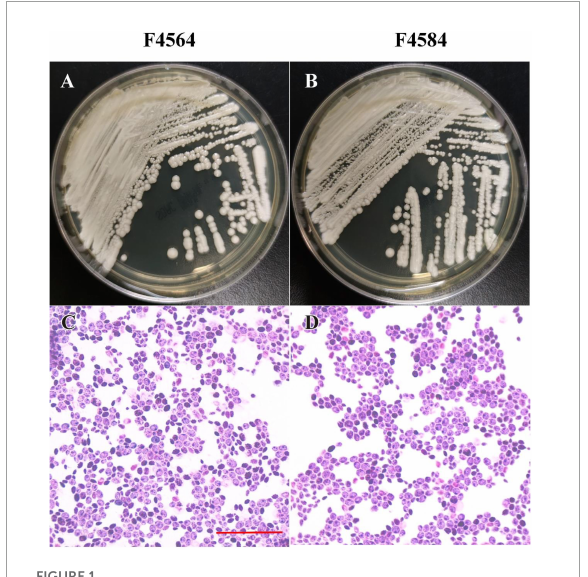
FIGURE1 Phenotypic characteristics of two C . haemulonii var. vulnera isolates on Sabouraud dextrose agar. The plate contains colonies with typical appearance of circular, smooth, and moist (A,B) . Microscopic examination showed budding yeast cells with Gram’s staining (C,D) . Scale bar = 10 µ m (C)